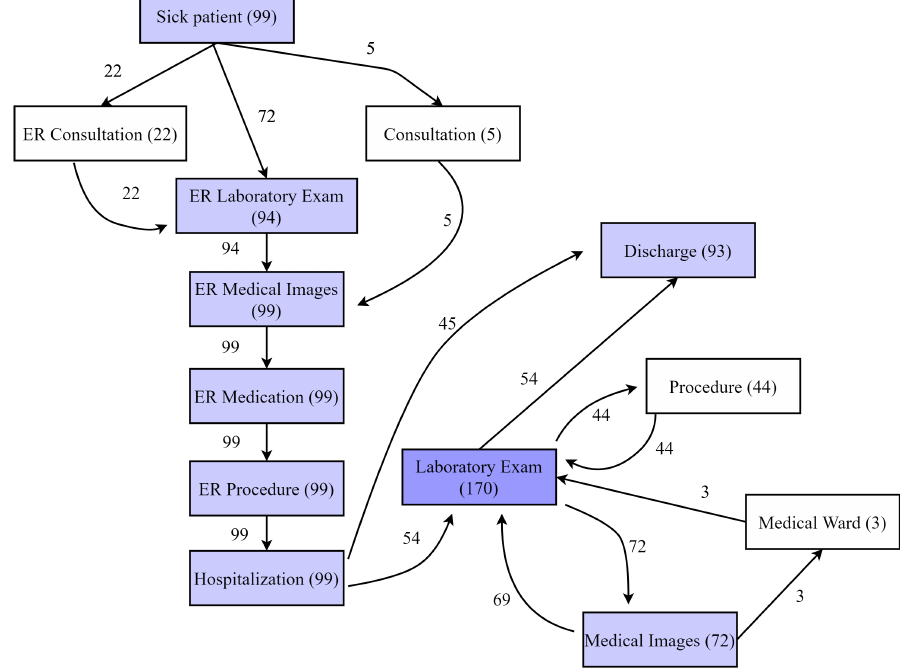
Figure 10. Process model discovered using DFG algorithm for patient treatment event